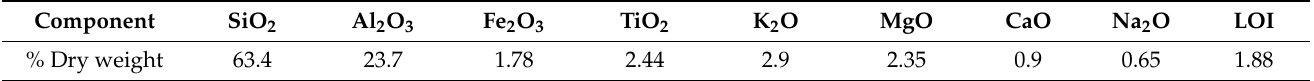
Table 3. Chemical properties of the as-received fly ash powder.